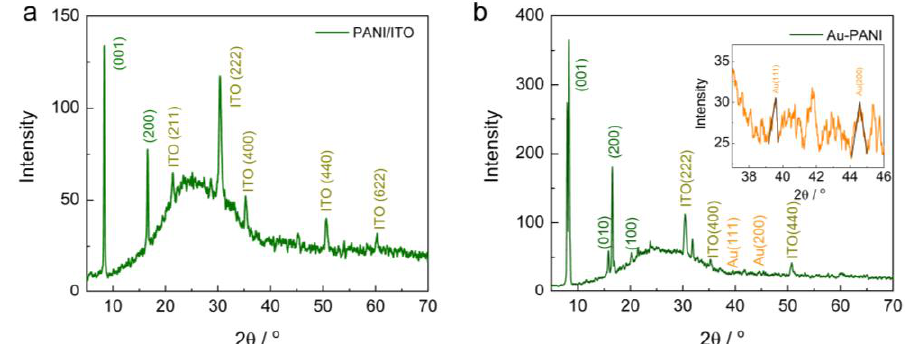
Figure 4. X-ray diffraction (XRD) patterns obtained for ( a ) PANI/ITO and ( b ) Au-PANI/ITO electrodes respectively; inset of Figure 4b shows the magnified view of the XRD peaks of Au nanoparticles in the range from 37 – 46 deg.